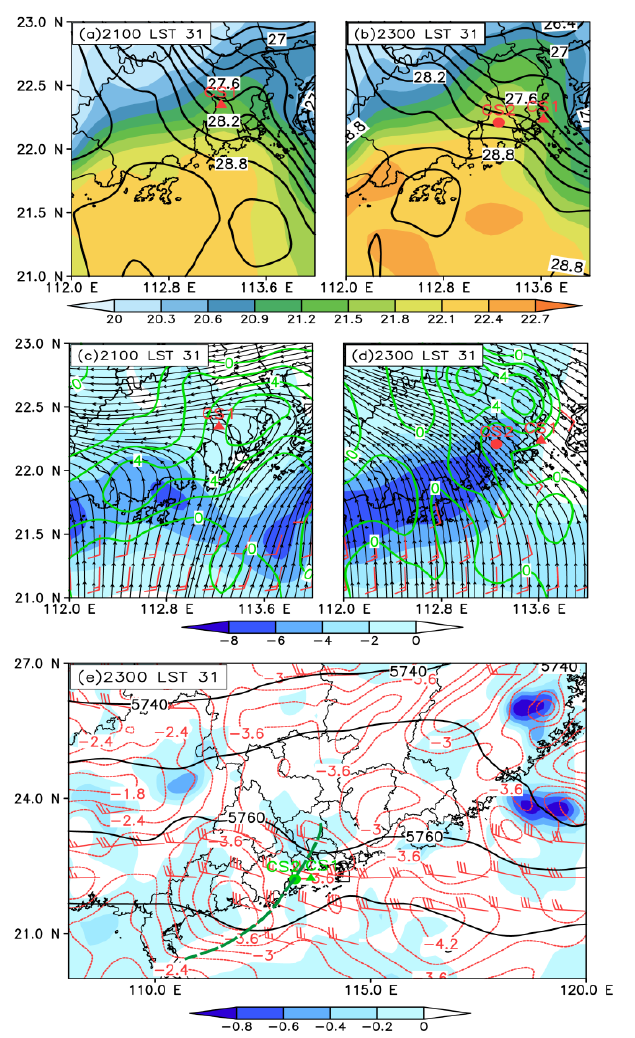
Figure 5. Synoptic background at 2100 LST on 31 May 2021( a , c ), 2300 LST on 31 May 2021 ( b , d , e ): ( a , b ) Temperature (contour; unit:°C) and specific humidity(color; unit: g kg − 1 ) at level 1000hPa (red triangle represents the center of CS1; red point represents the center of CS2). ( c , d ) Divergence (color; unit: 10 − 5 s − 1 ), relative vorticity (contour; unit: 10 − 5 s − 1 ), and wind (stream; unit: m s − 1 ) at level 1000 hPa (red color: wind speed ≥ 4 m s − 1 ). ( e ) Vertical velocity (color; unit: Pa s − 1 ), geopotential height field (black contour; unit: gpm), air temperature (red contour; unit: °C), and wind (barb unit: m s − 1 ) at level 500 hPa (red color: wind speed ≥ 10 m s − 1 ; green triangle represents the center of CS1; green point represents the center of CS2). The thick green dashed line represents the trough line.